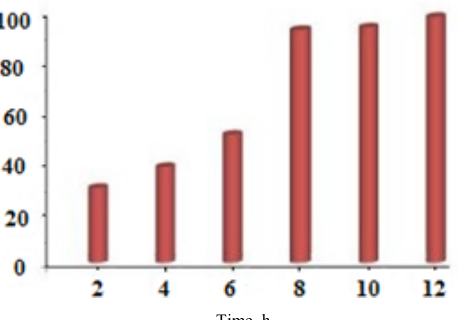
Figure 3. The effect of time on epoxidation of trans –stilbene using cobalt (acac) 41as catalyst.